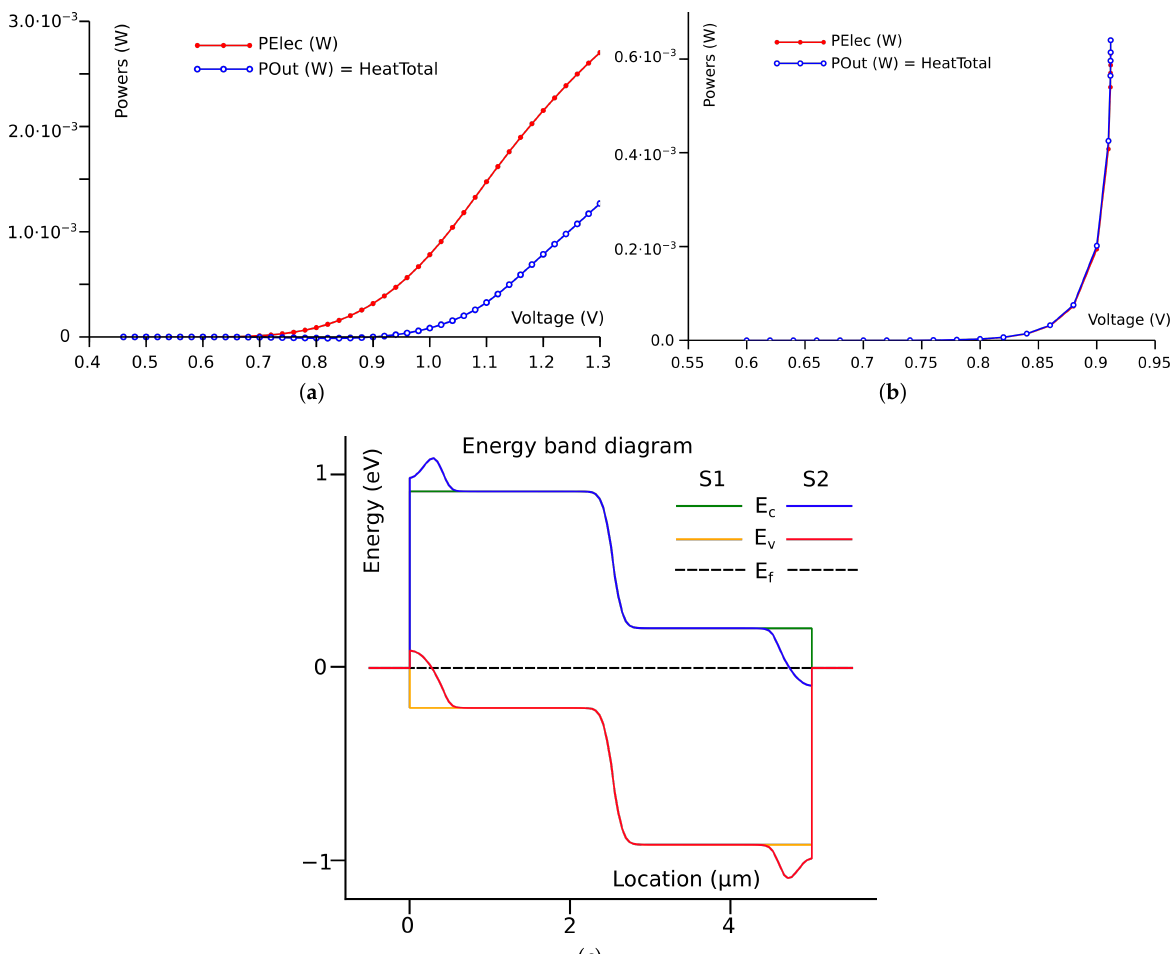
Figure 4. Power balance and the energy band diagrams for Si structures S1 and S2; geometry parameters are: C = 0.5 µ m, = N + = 10 21 cm − 3 , D = 0.5 µ m. ( a ) Input and output powers for S1; ( b ) input and output powers for S2; P + pd Dmax Amax ( c ) energy band diagrams for S1 and